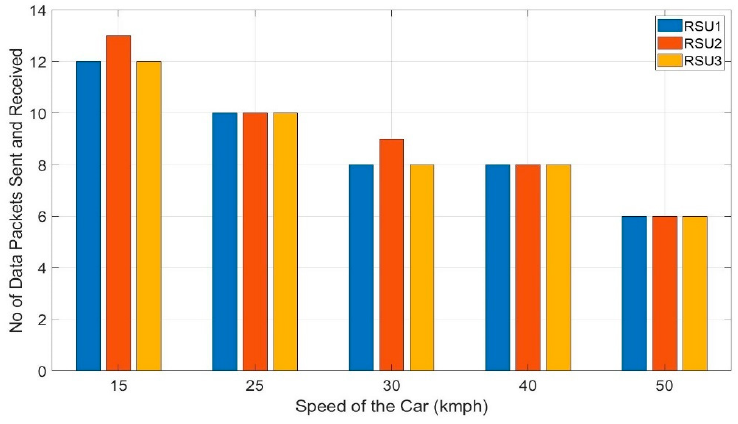
ff erent speeds of the car with Kalman